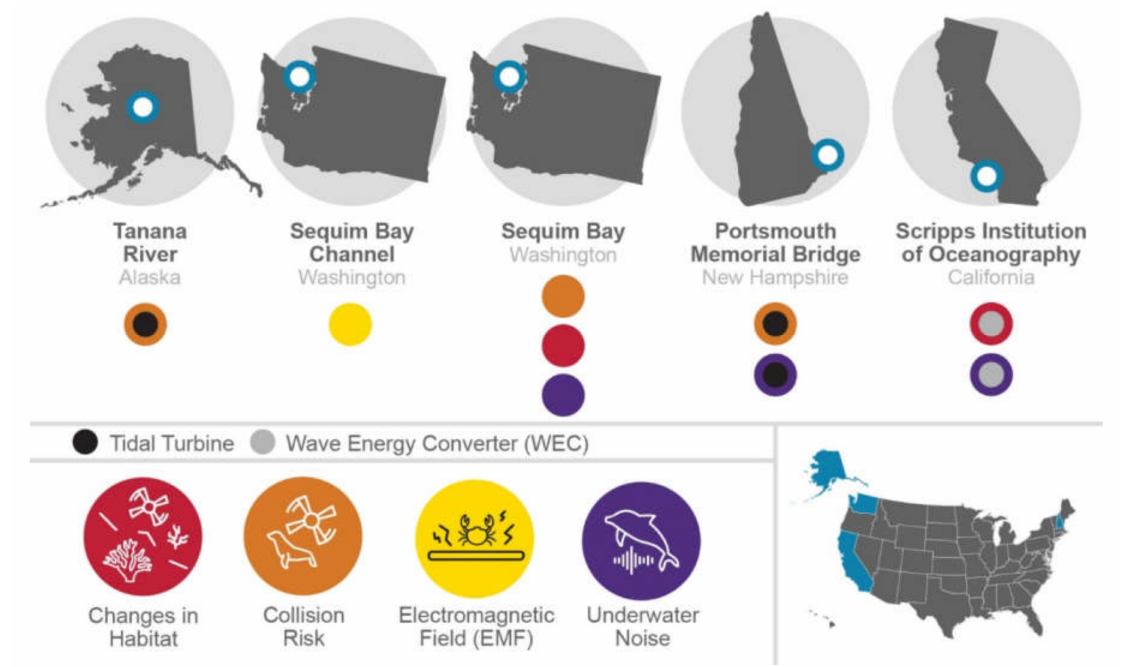
Figure 1. Technology and field trial locations for each stressor. Illustration modified from [7] to include energy device types (illustration by Stephanie